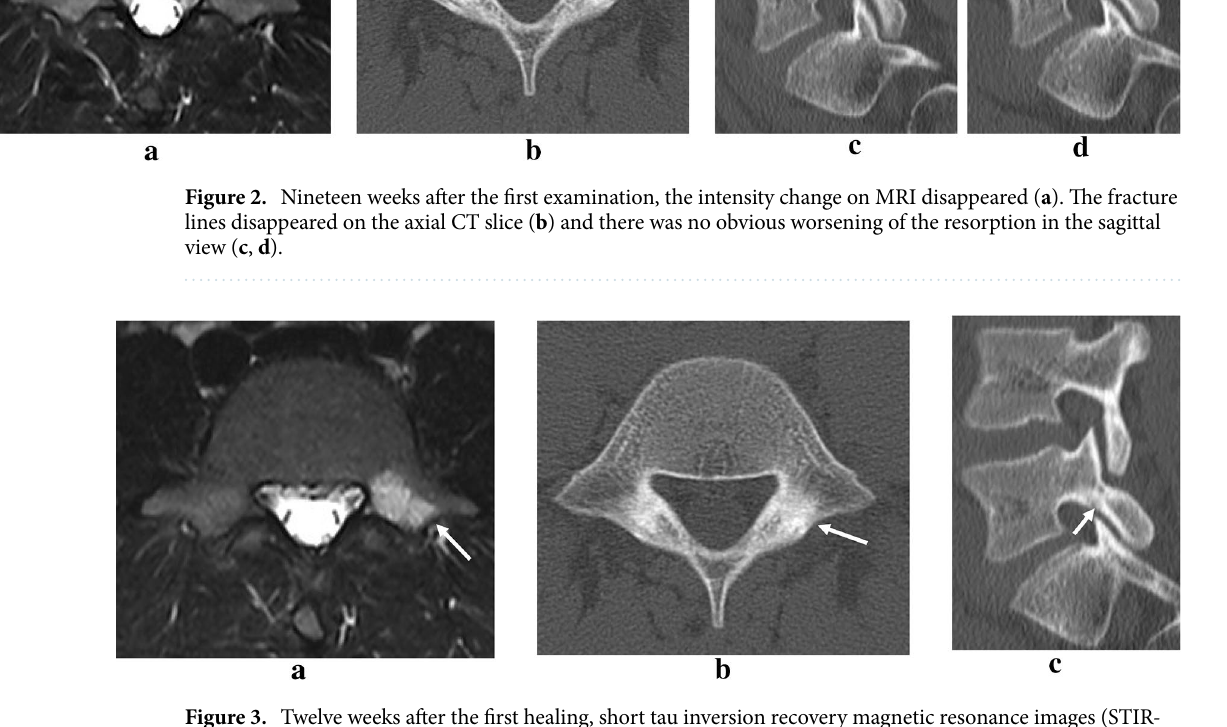
Figure 3. Twelve weeks after the first healing, short tau inversion recovery magnetic resonance images (STIR- MRI) showed high intensity change (white arrow) on only the left side ( a ). CT revealed no fracture line (white arrow) in the axial view ( b ) but slight bone resorption (white arrow) on the ventral side in the sagittal view ( c ).